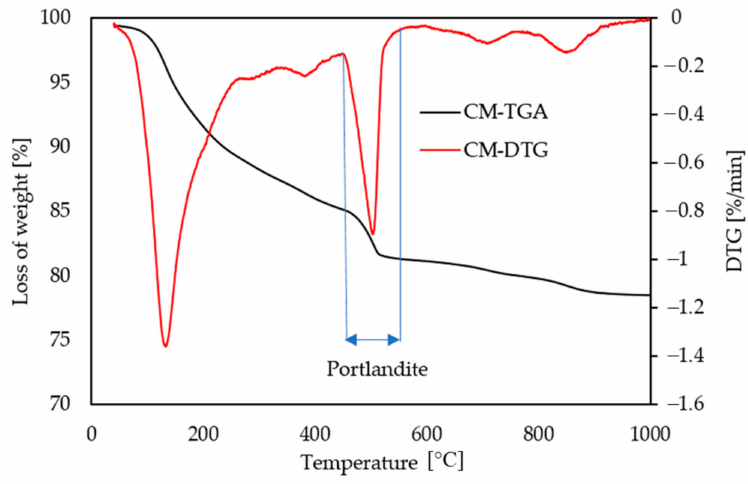
Figure 7. Thermogravimetric analysis (TGA) and DTG versus